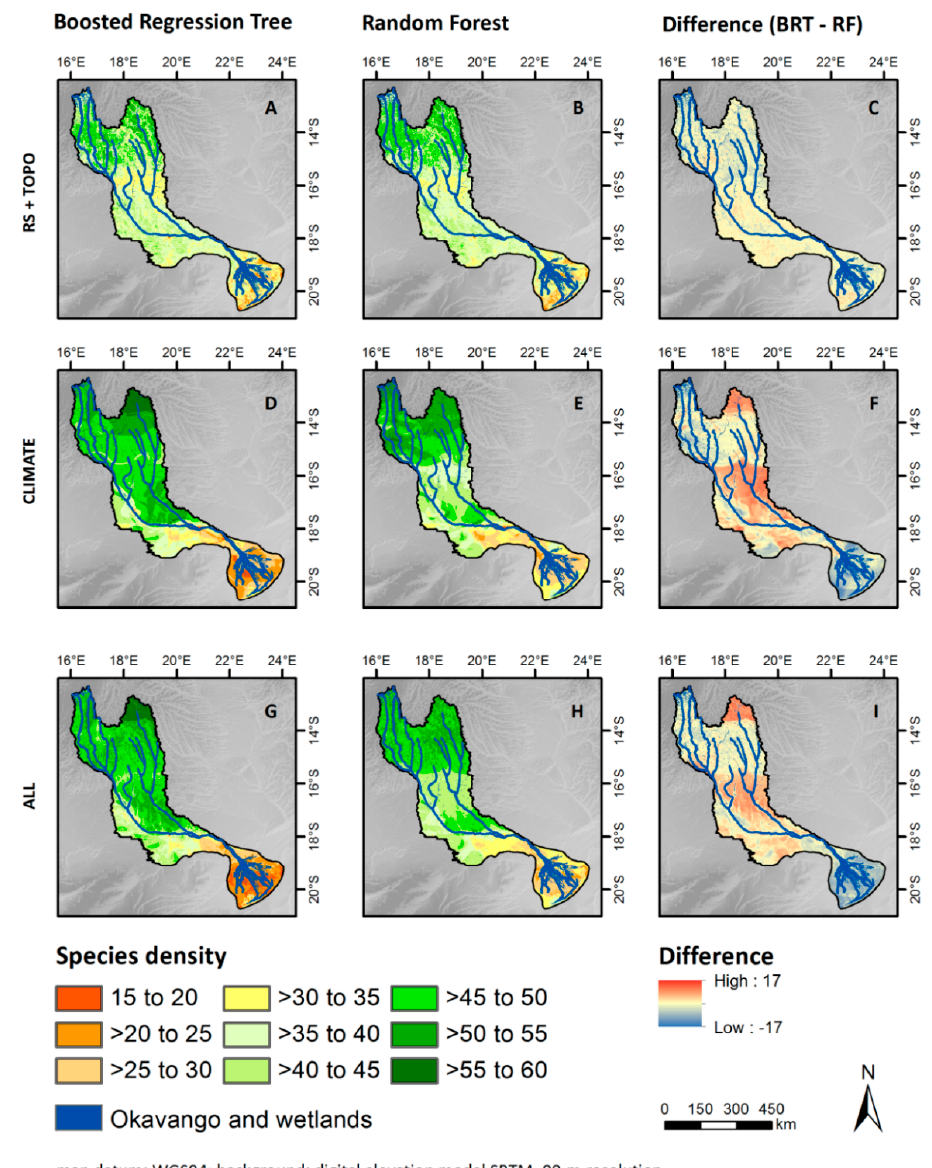
Figure 4. Plant alpha diversity (species density per 10 3 m 2 ) in the Okavango Basin predicted by boosted regression trees (BRT) and random forests (RF) and the difference between the two model algorithms displayed for the three datasets ‘ RS TOPO ’ (A,B,C), ‘ CLIMATE ’ (D,E,F), and ‘ ALL ’ (G,H,I). BRT (A,D,G), RF (B,E,H), difference (C,F,I). For a map on observed species density, see Figure S2.